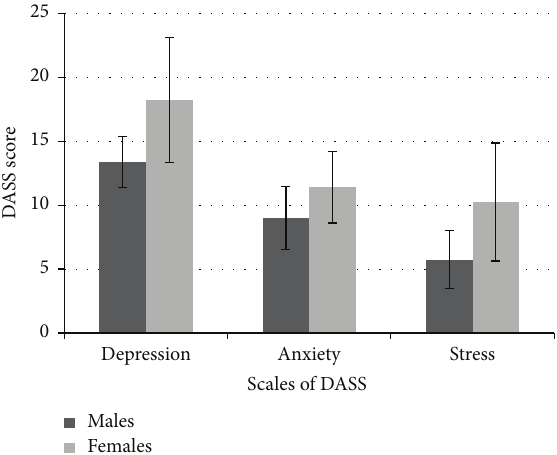
Figure 2: The mean and SD of DASS scores for the three subscales across